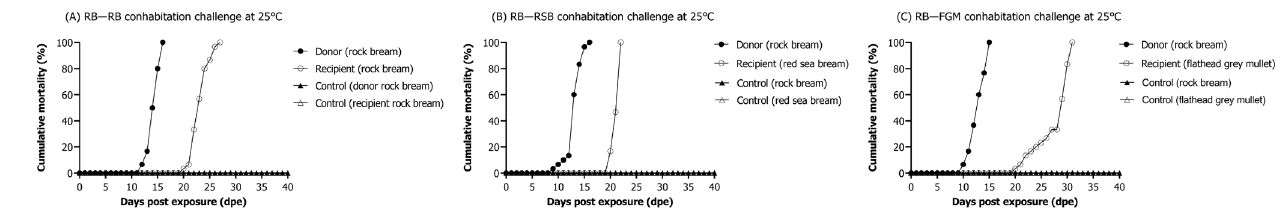
Figure 7. ( A − C ) Cumulative mortality after cohabitation challenges was evaluated in naïve rock bream ( Oplegnathus fasciatus ), red sea bream ( Pagrus major ), and flathead grey mullet ( Mugil cephalus ) recipients with donors of rock bream that were intraperitoneally (IP) injected with red sea bream iridovirus (10 6 RSIV copies/fish) at 25 °C. The control group of donors was IP injected with 100 µL of L-15 medium (virus-free), and the recipients were not treated in any way. No mortality was observed at 15 °C.